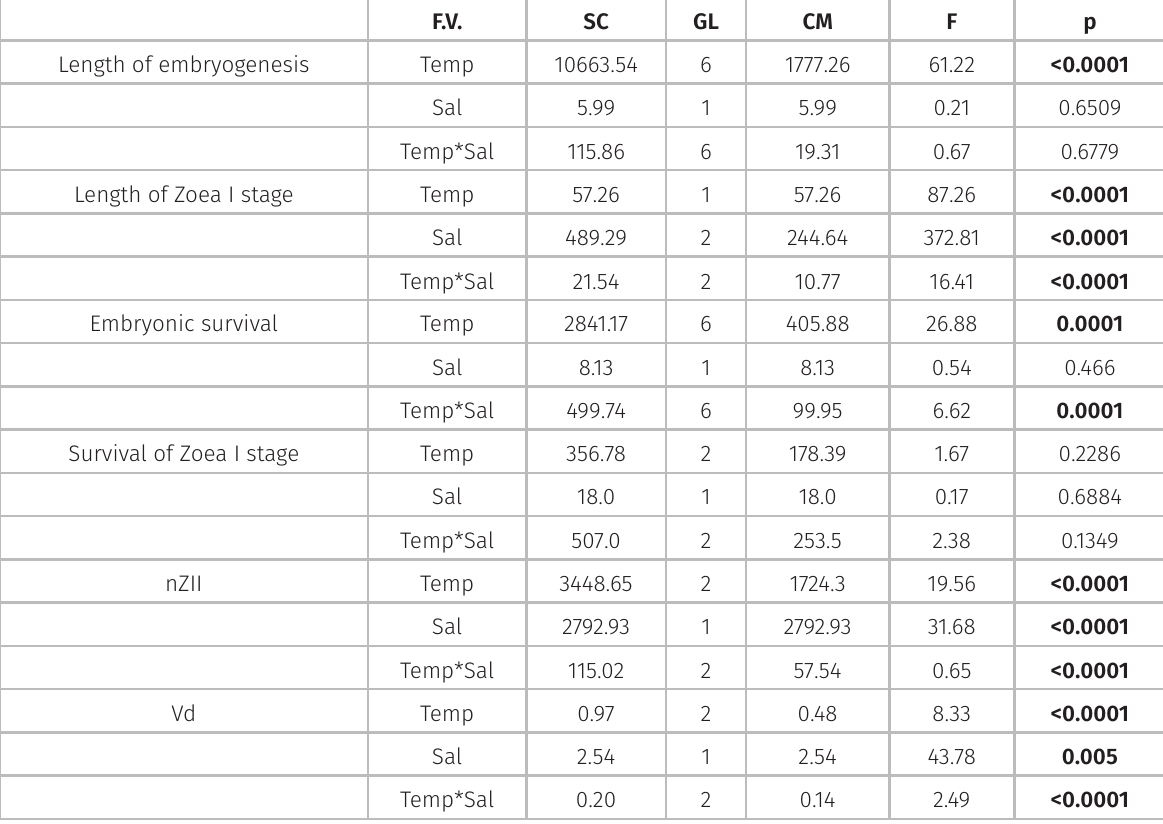
Table II. Two-way ANOVA’s for different variables of embryos and zoeae of Ovalipes trimaculatus subjected to different thermo-haline treatments within 6-24 ⁰C and